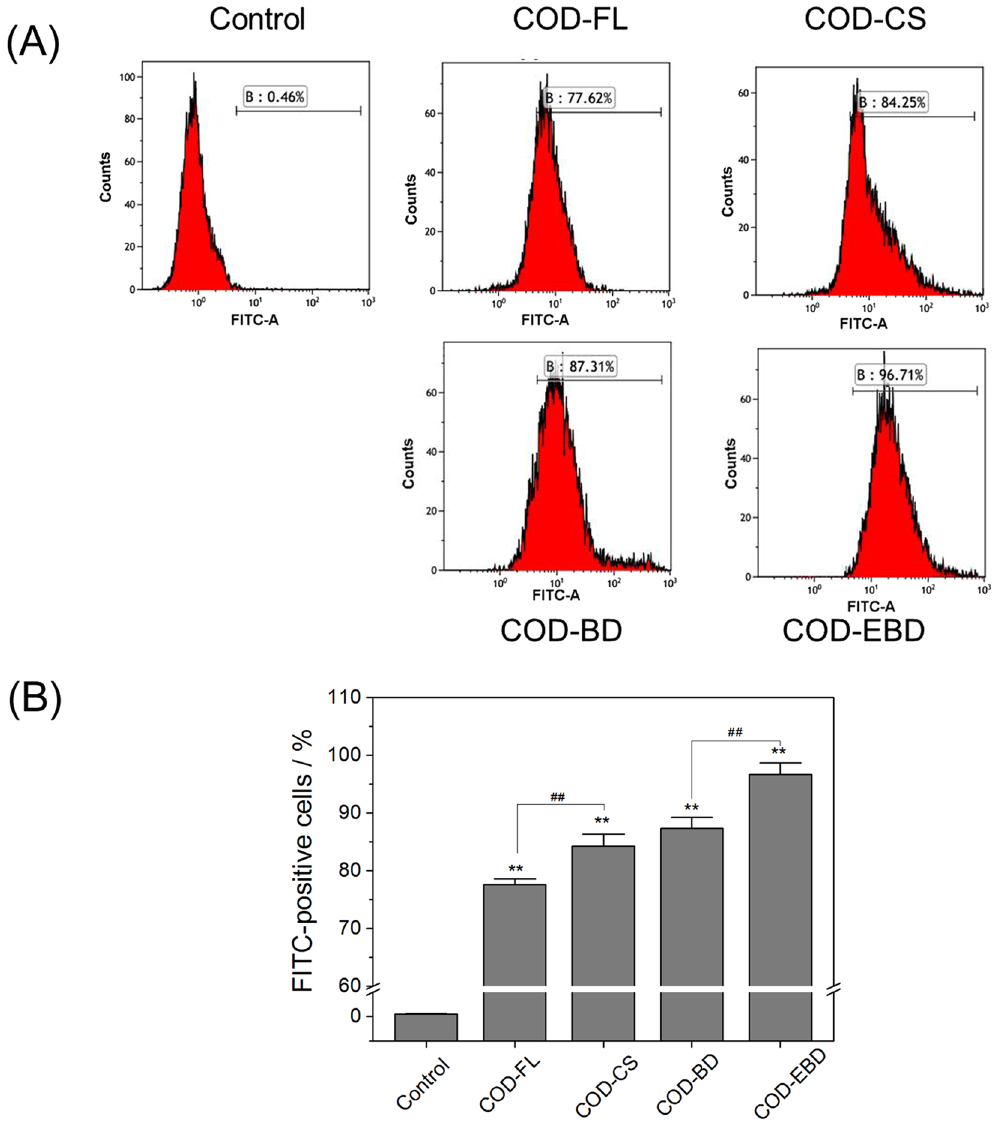
Figure 8. Quantification of adhesion amount of COD crystals with various shapes on cell surface by flow cytometer. ( A ) Histogram of the percentage of FITC-positive cells. ( B ) Quantitative results of adherent crystals. [A] FITC-A means fluorescent intensity; B means percentages of cells with adherent fluorescent COD crystals. Crystal concentration: 400 μ g/mL, treatment time: 1 h. Compared with control group, * p < 0.05. ** p < 0.01. COD-FL treatment group vs corresponding concentration of COD-CS treatment group, COD-BD treatment group vs corresponding concentration of COD-EBD treatment group, # P < 0.05, ## P <